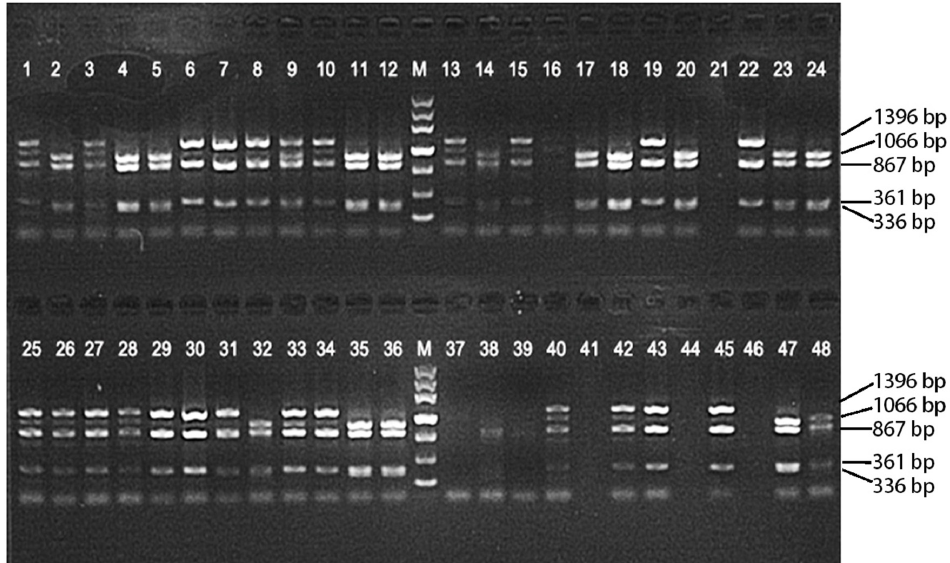
Figure 4. CCD7-B allelic variation for the less and more tiller number in Chinese wheat micro-core collections (MCC-CN). The names of MCC-CN wheat genotypes are given on the gel image: 1. Jinghong 5, 2. Neimai 11, 3. Jinchun 3, 4. Lianglaiyoubaipixiaomai, 5. Bihongsui, 6. Xiaobaimai, 7. Hong-